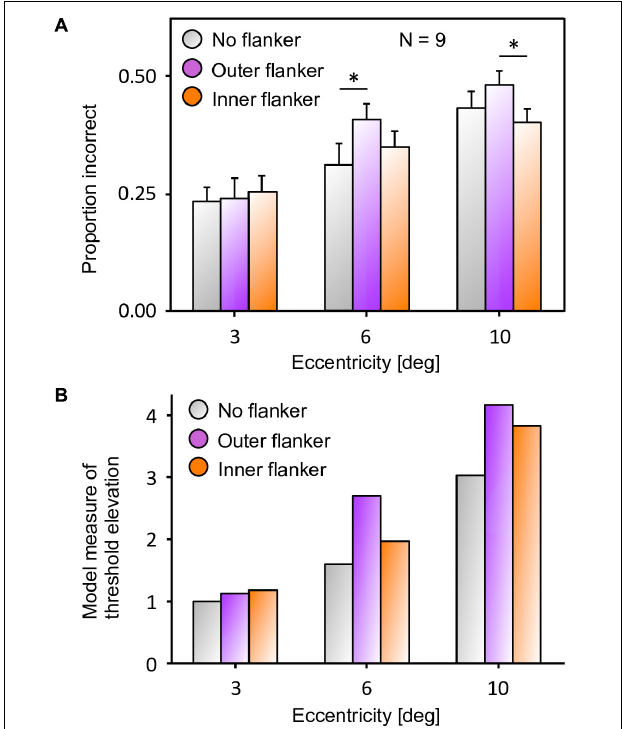
FIGURE 13 | (a) Data from experiment 5 of Farzin et al. (2009), that measures inward-outward anisotropy in visual crowding with Mooney faces. The figure has been re-drawn from Figure 3C as bars that report the proportion of incorrect trials, to compare to the model results. Here, a value closer to the top corresponds to a bad performance, like in a threshold measure. The amount of inward-outward anisotropy (how much the inner flanker condition differs from the outer flanker condition) varies with eccentricity. The stars indicate significant differences between conditions. (B) Threshold elevation measurement obtained with the simulation of the full visual system (retina, saliency, and segmentation), reproducing all conditions of the original experiment on the NRP. To compute the threshold elevation for each condition, we divided each threshold by the threshold of the unflanked condition at 3 ◦ of eccentricity (the lowest threshold value). The model threshold measurements highlight the same interaction as in the data, between the eccentricity and the amount of inward-outward anisotropy. Ranking the model threshold elevation measurements from the lowest to the highest value almost perfectly matches the data, ranking from the highest to the lowest performance. The only difference is that the threshold elevations that the model produces for the unflanked and the inner flanker condition are swapped at 10 ◦ of eccentricity (the model predicts that the unflanked condition is always better than both flanked conditions at the same eccentricity). In terms of quantitative differences, the model produces more inward-outward anisotropy for 6 ◦ than for 10 ◦ of eccentricity, which does not fit the data (the data shows a significant difference between the inner and the outer flanker condition for 10 ◦ but not for 6 ◦ of